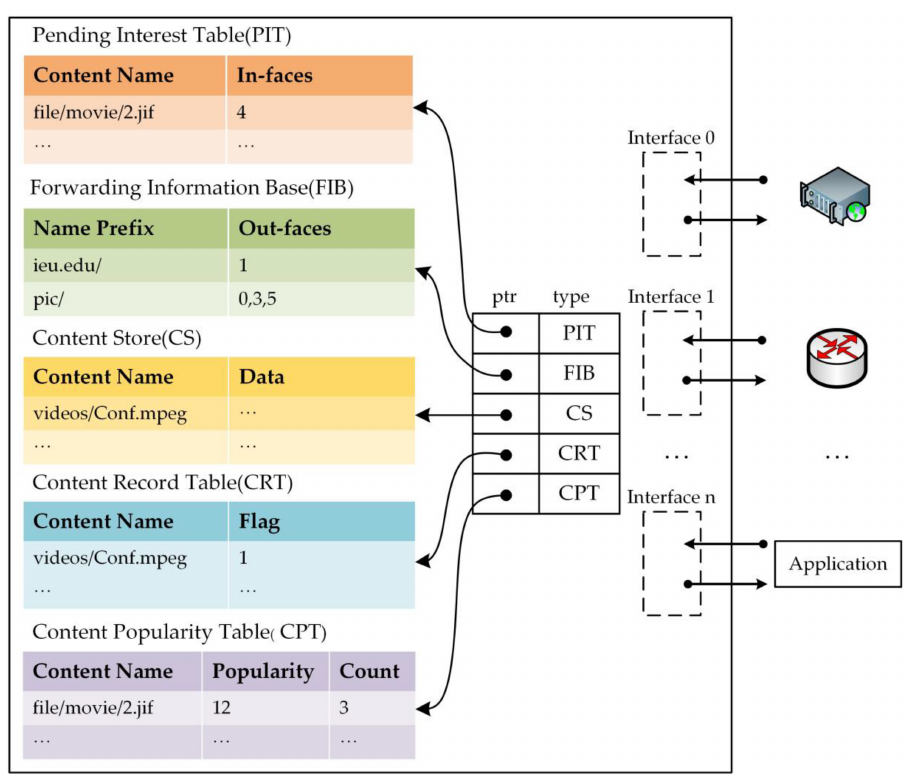
Figure 2. NDN node and forwarding